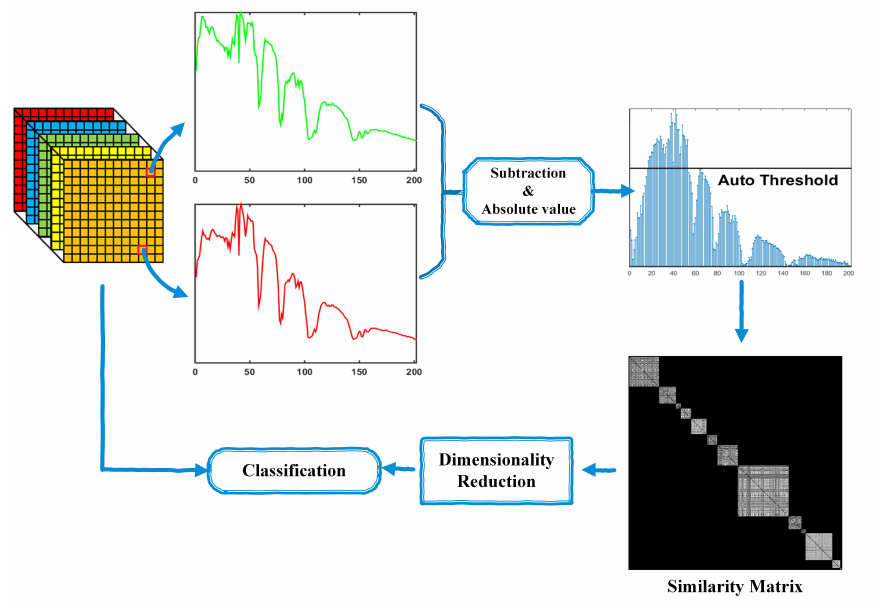
Figure 1. The flowchart and the motivation of the proposed